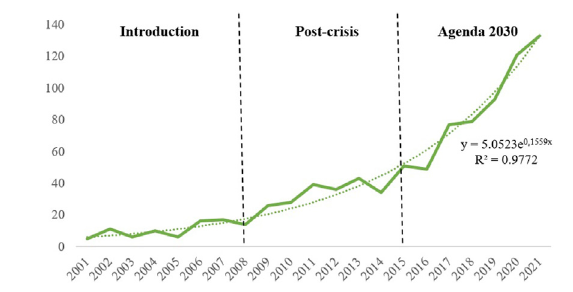
FIGURE 2 | Annual evolution of the number of published papers. Source: Authors ’